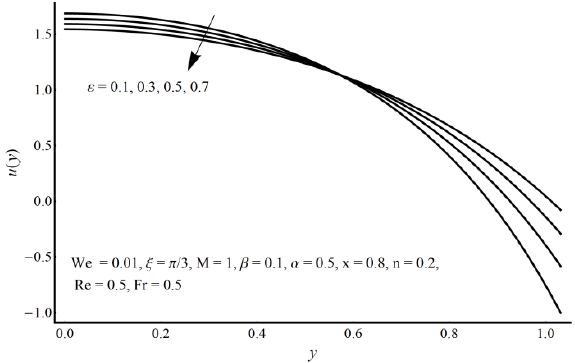
Figure 1. The velocity profile for different values of variable ε.